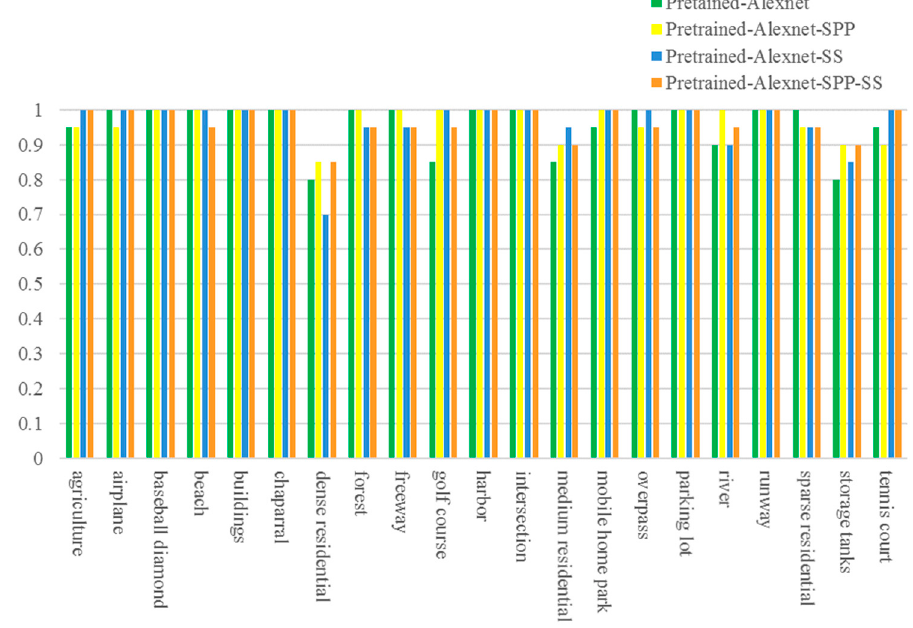
Figure 9. Classification accuracies of each category for the different algorithms with the UC Merced dataset.